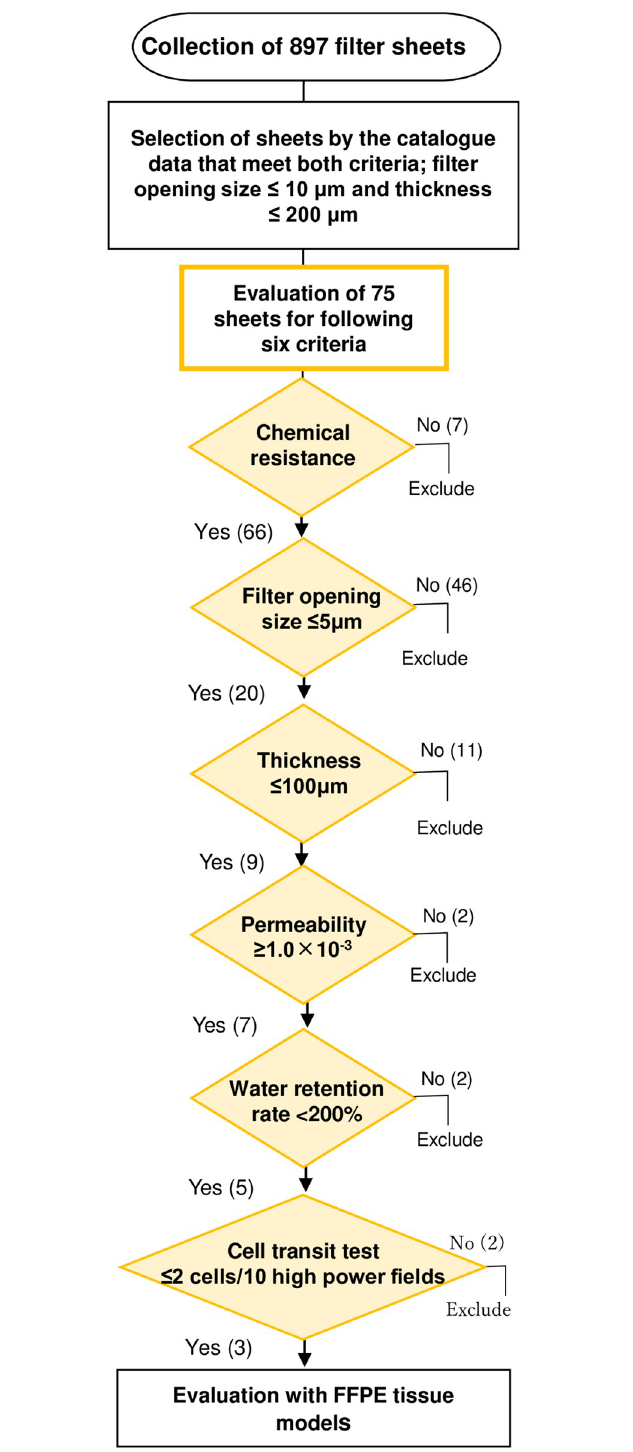
Fig 2. Workflow of sheet selection. Summary of selection strategy and criteria for sub-selection.